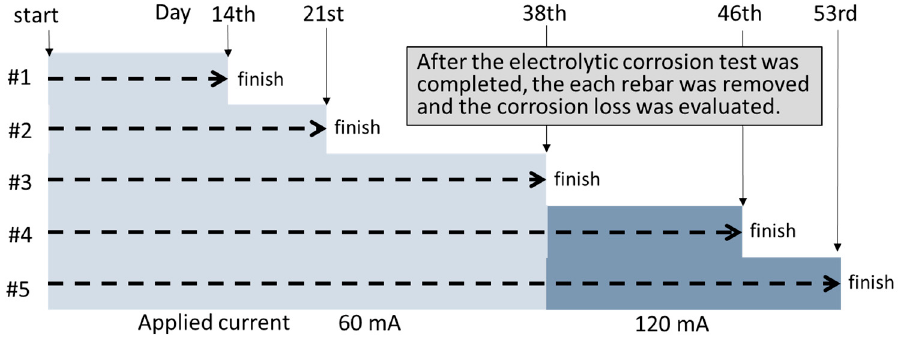
Figure 9. Protocol of the electrolytic corrosion test.